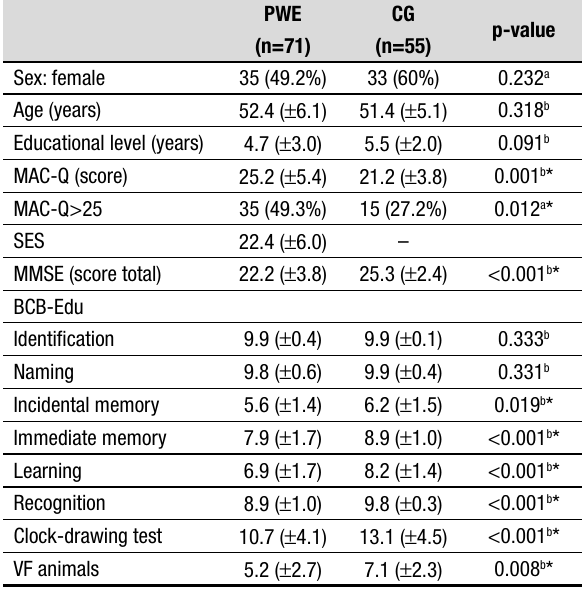
Table 1. Demographic, clinical, and cognitive data of people with epilepsy and individuals in the control